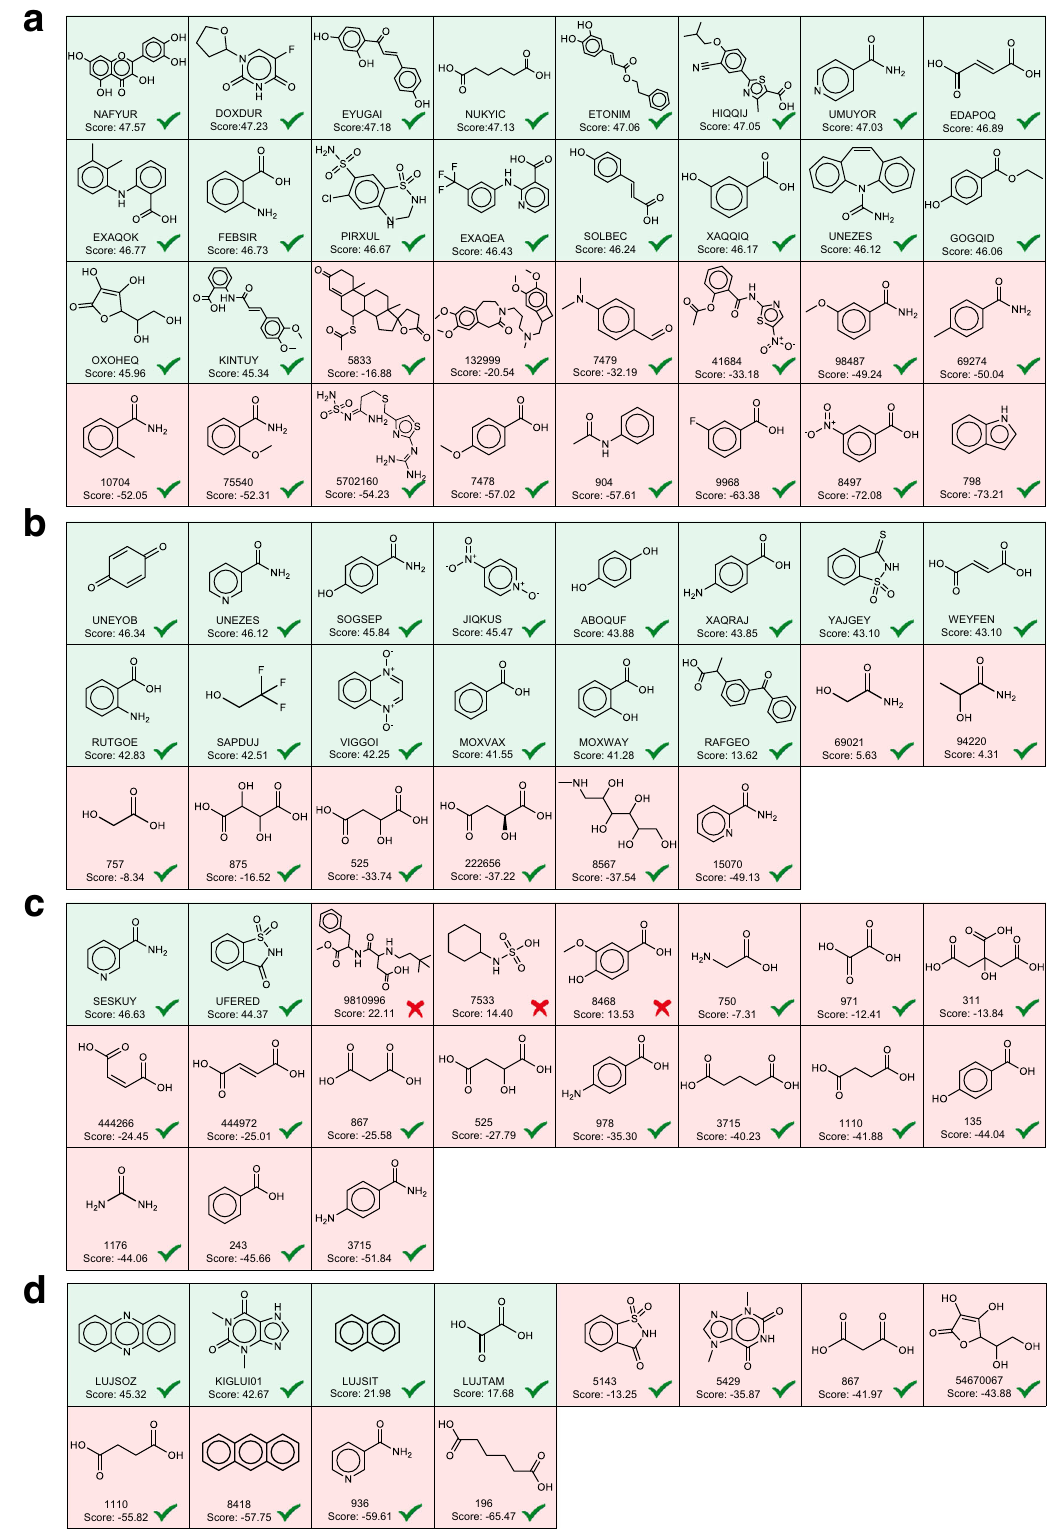
Fig. 4 The predictive score ranking of CCGNet for the independent test sets of the four APIs. a Coformers of nicotinamide. b Coformers of carbamazepine. c Coformers of paracetamol. d Coformers of indomethacin. The scores are listed from high to low. The coformer of the positive sample is labeled as the CSD refcode while the negative sample is named in terms of PubChem Compound ID. Green background denotes true positive sample while red background represents true negative sample. The green and red ticks denote the correct prediction and the wrong prediction,